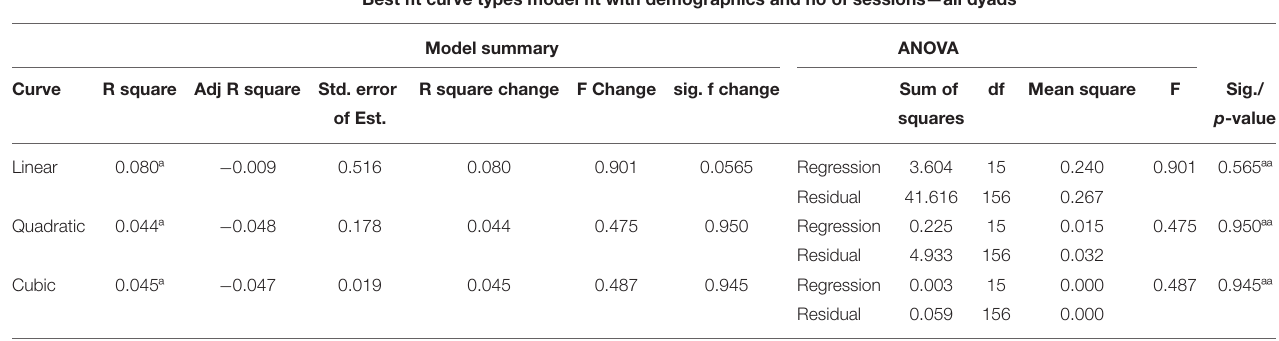
TABLE 4 | Model fit with demographics and no of sessions. Best fit curve types model fit with demographics and no of sessions—all dyads Model summary